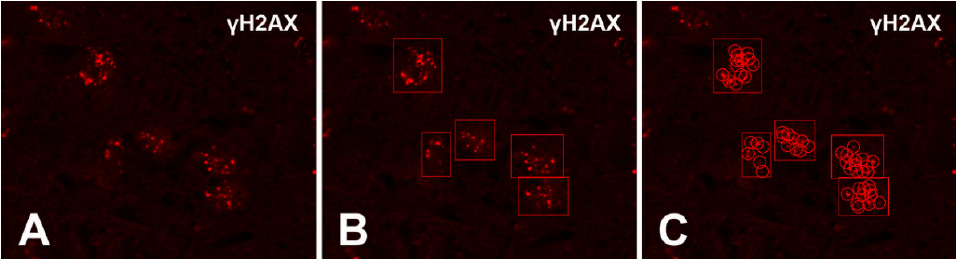
Figure A2. Exemplificative images of the procedure to automatically count foci with Foci Counter in the cerebral cortex of a 15 min irradiated mouse. ( A ) plain image; ( B ) manual identification of nuclei for foci counting; ( C ) automated foci count. Original magnification 100×.